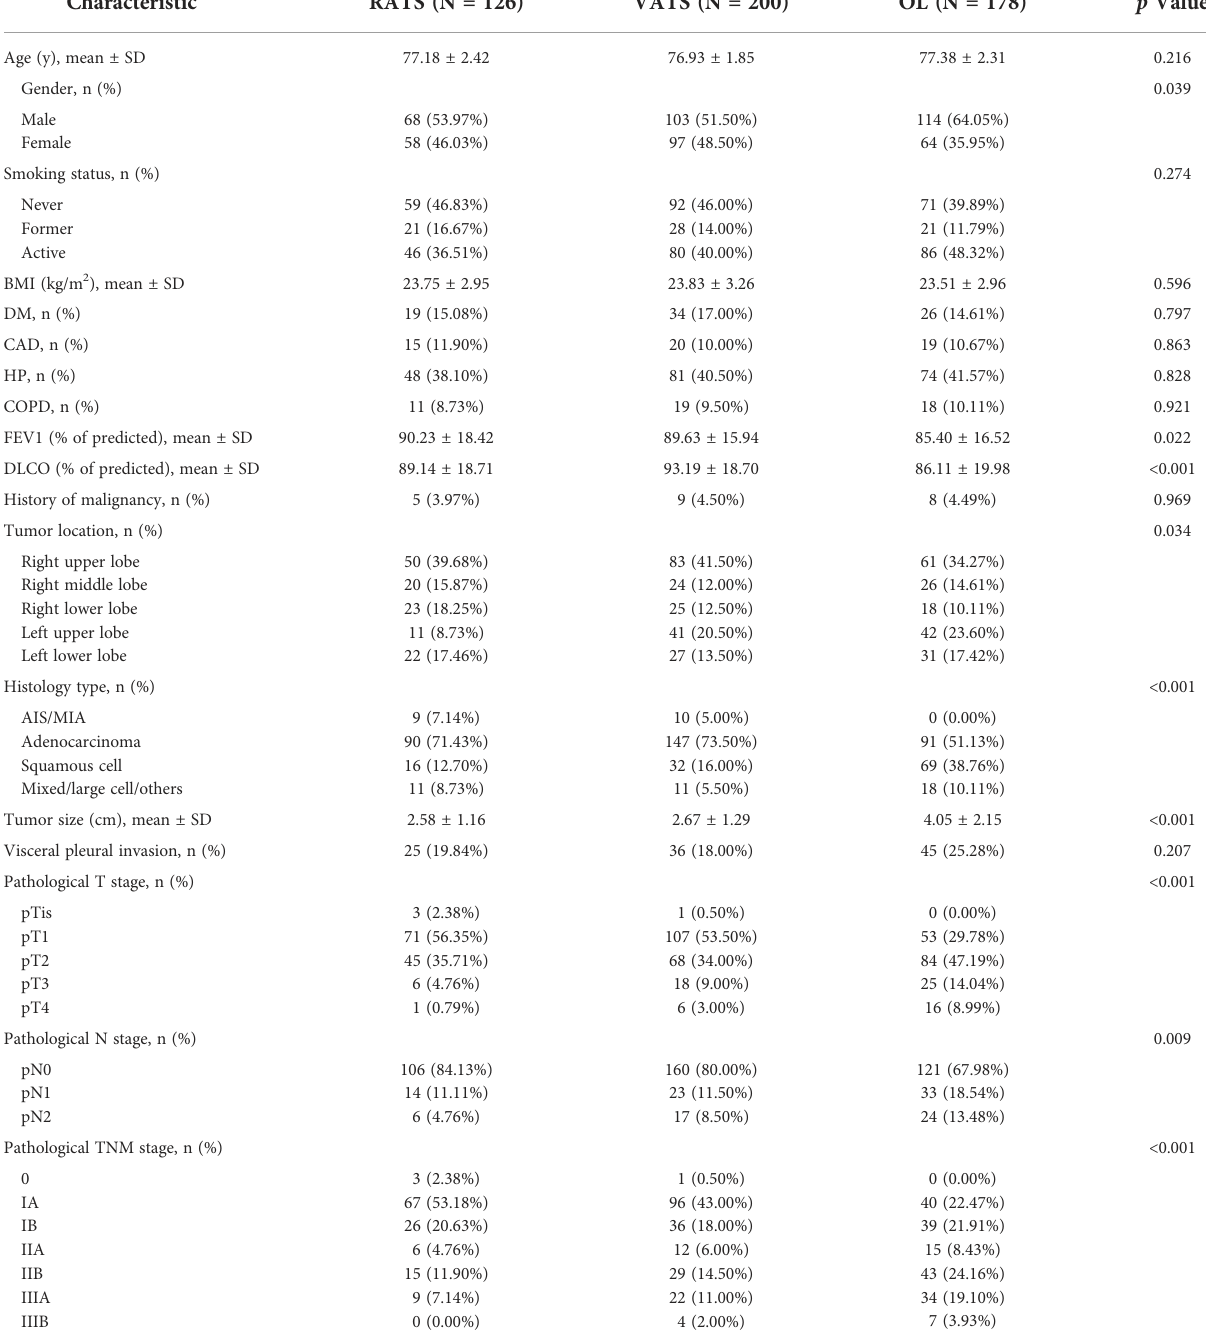
TABLE 1 Baseline clinicopathological characteristics of unmatched